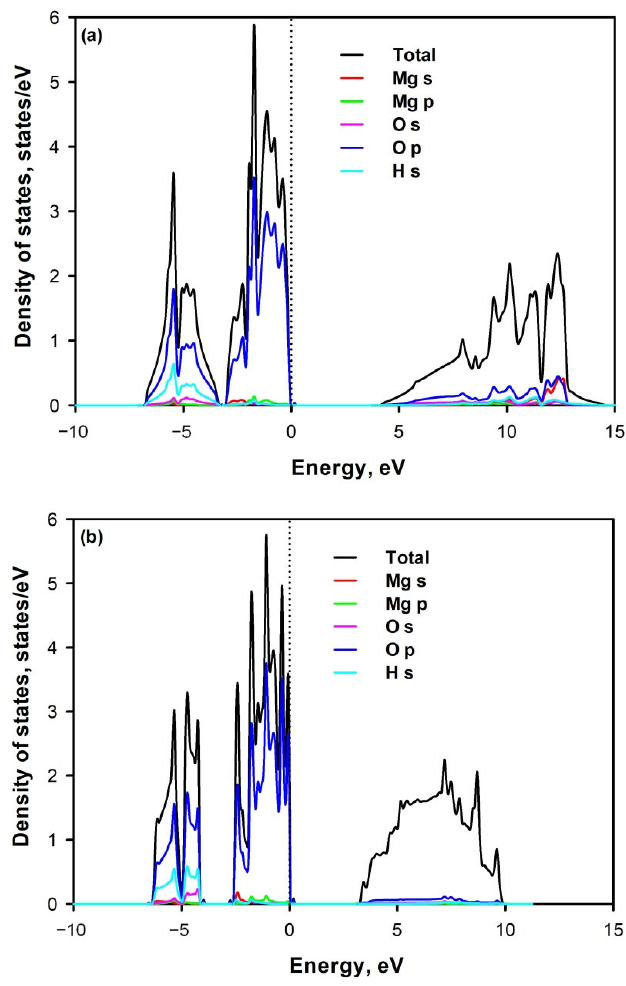
Figure 1. Total and partial density of states (PBE) of ( a ) bulk and ( b ) 2D Mg(OH) 2 . The Fermi level is set as zero energy.